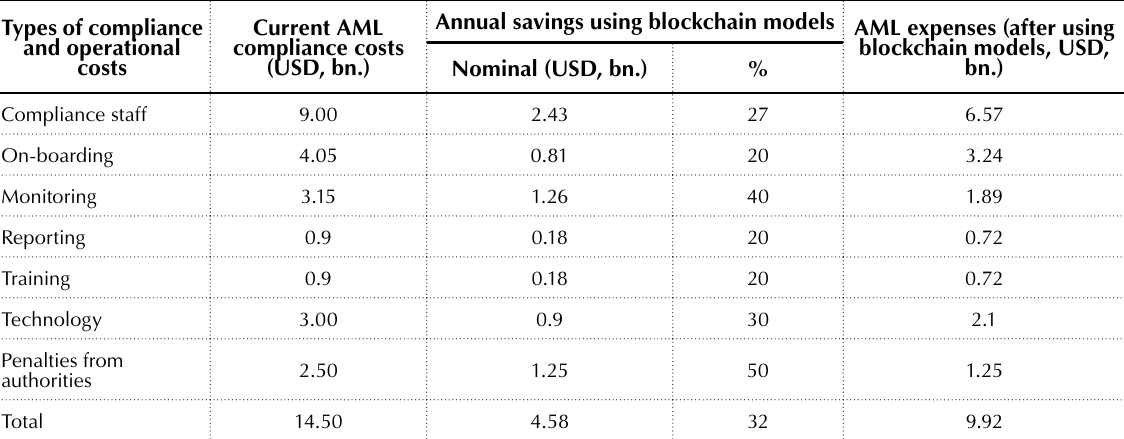
Table 3. Anticipated annual AML cost savings in CBRs using Fintech models